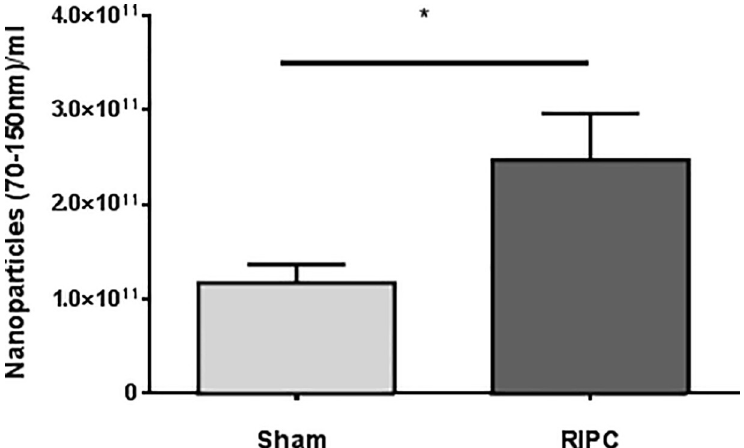
Fig 4. Arterial nanoparticle concentration of patients after RIPC or Sham interventions as analyzed by Nanoparticle Tracking Analysis (NTA). Total serum EV-concentration between 70-150nm/ml obtained from patients 60 minutes after RIPC or Sham treatment. Values are means ± SEM; n = 5 ( � p < 0.05). https://doi.org/10.1371/journal.pone.0228948.g004 isoflurane or propofol per se neither had a protective nor a damaging effect on cells during hypoxia. (Fig 5B).